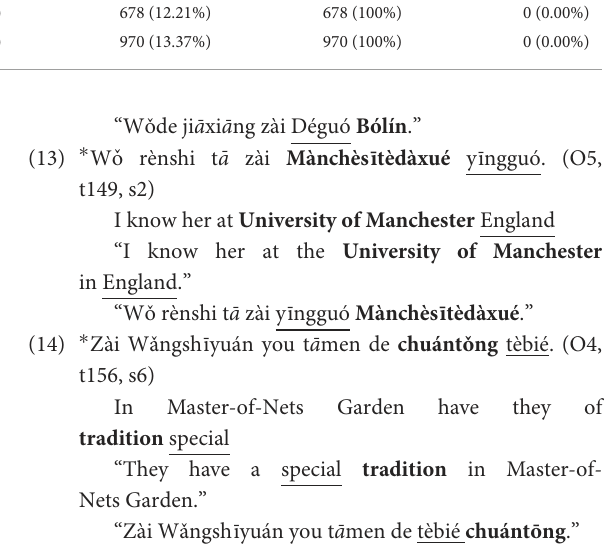
The typological developmental features